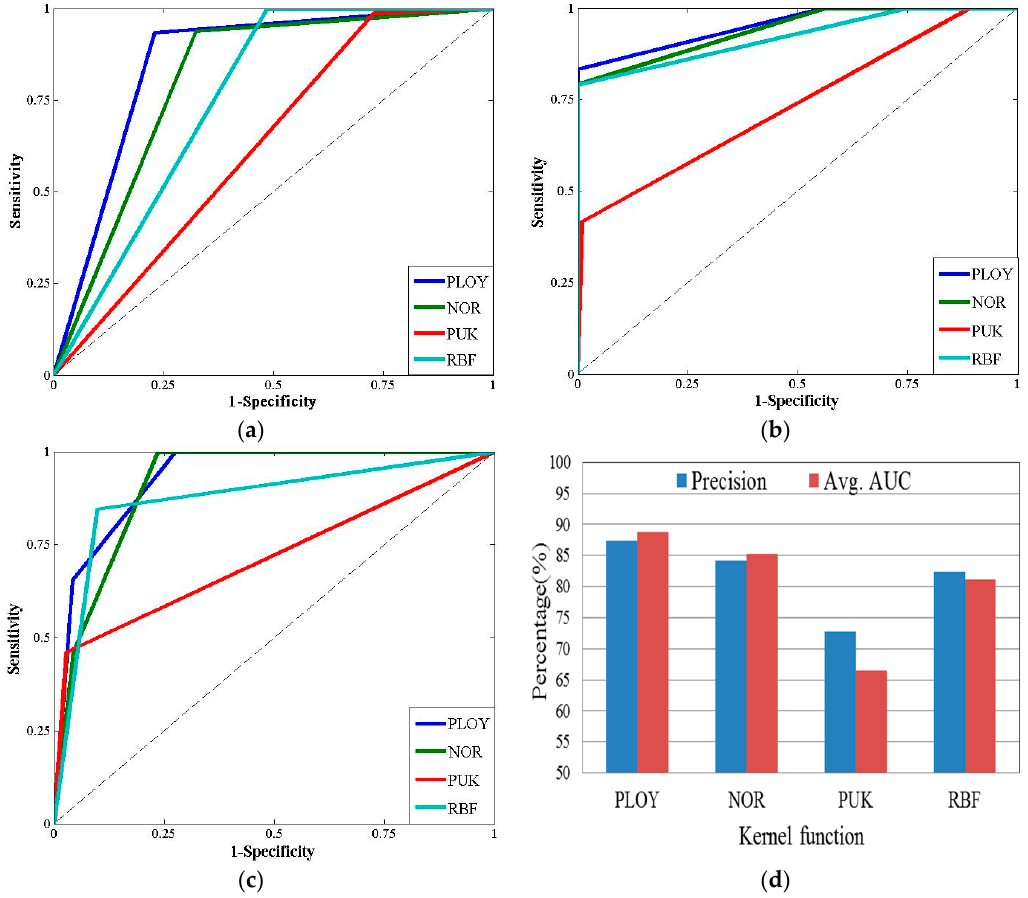
Figure 10. Results of different kernel functions. ( a ) The ROC curve of safe traffic events; ( b ) The ROC curve of risky traffic events; ( c ) The ROC curve of hazardous traffic events; ( d ) The AUC and precision.